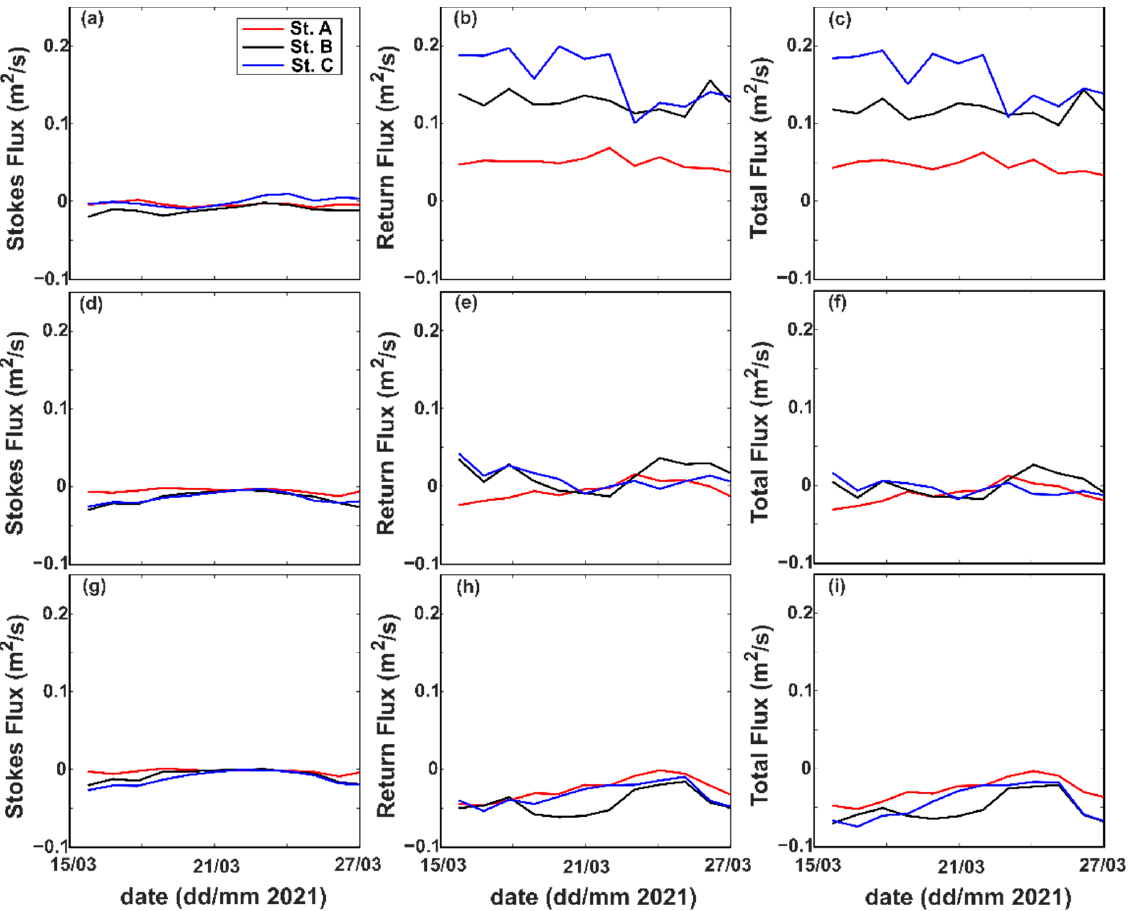
Figure 9. Stokes flux ( a , d , g ), return flux ( b , e , h ), and total flux ( c , f , i ) at upper (top row), mid- (middle row), and lower depth (bottom row) at Stations A, B, and C.